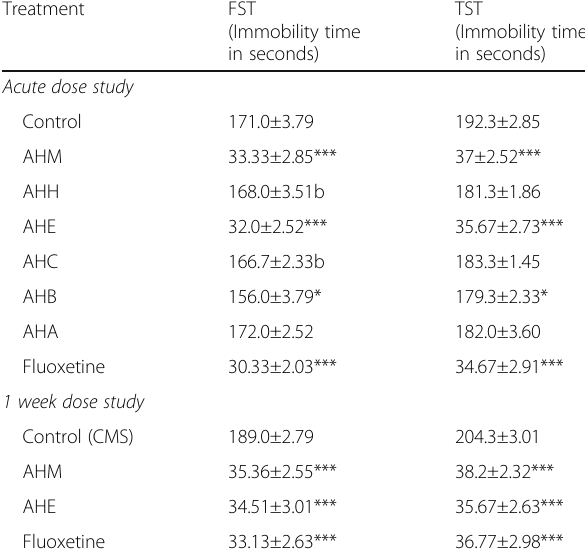
Table 2 Antidepressant like effect of A. hydaspica in acute and repeated doses in FST and TST (Immobility behavior) models